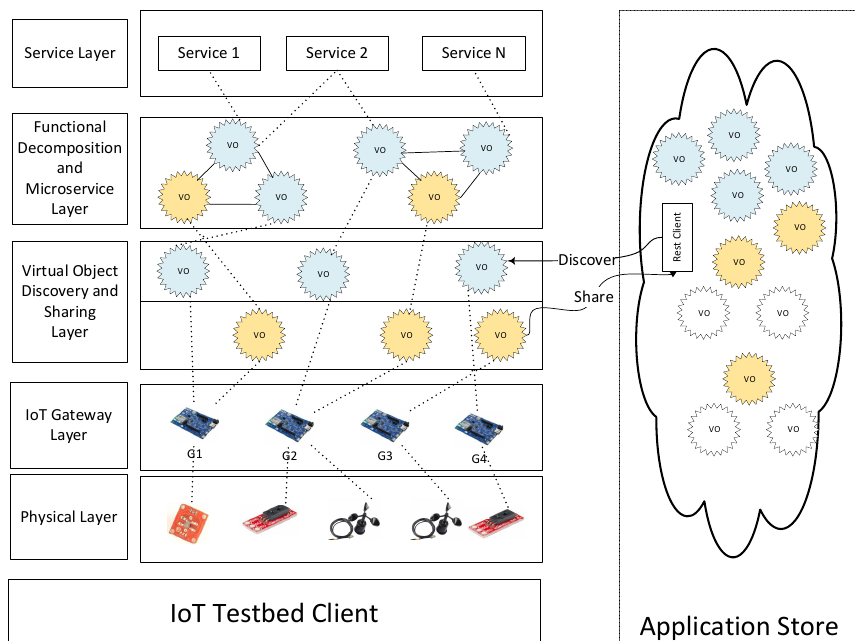
Figure 3. Internet of things (IoT) testbed client